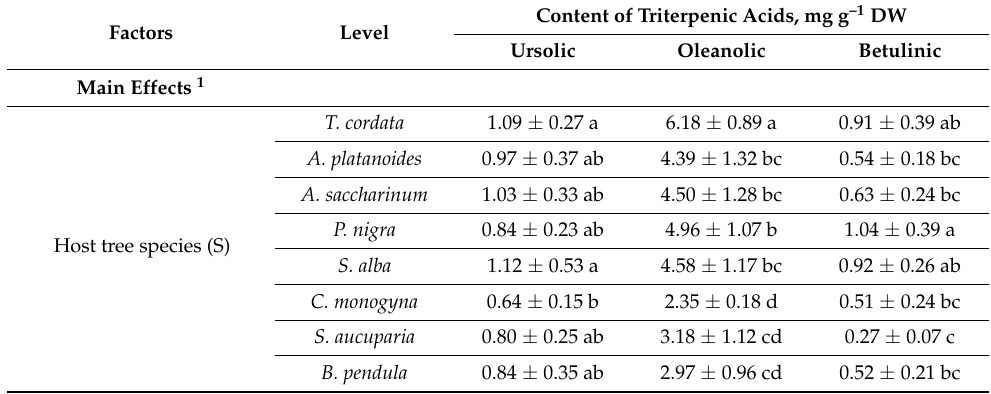
Table 3. Content of triterpenic acids in mistletoe, depending on host tree species and type of mistletoe